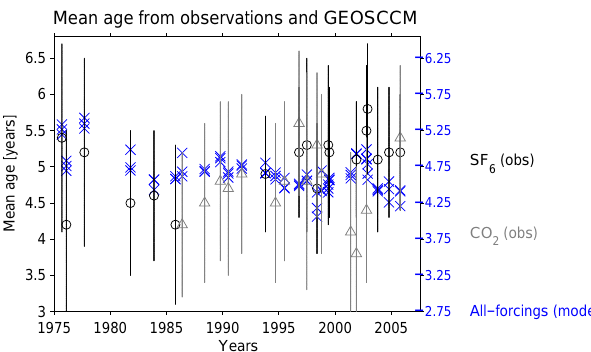
Figure 12. Mean age estimates in the data from Engel et al. (2009) in the NH mid-stratosphere between 30 and 5hPa and in the three all-forcing integrations for the same locations and months (results are similar if we use 30 to 10hPa). The uncertainty for the obser- vational estimates is taken from Engel et al. (2009), and the un- certainty of the model simulated mean age can be deduced from the intra-ensemble spread. The GEOSCCM mean age is offset by 3 months, i.e., the bias in the mean age (which is less than the 6- month uncertainty in the observed mean age as evaluated by Engel et al.,